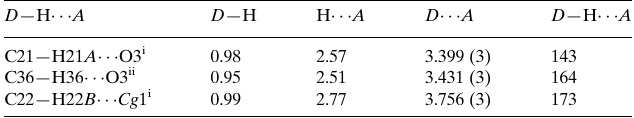
Hydrogen-bond geometry (A˚ , (cid:5) ). Cg 1 is the centroid of the C31–C36